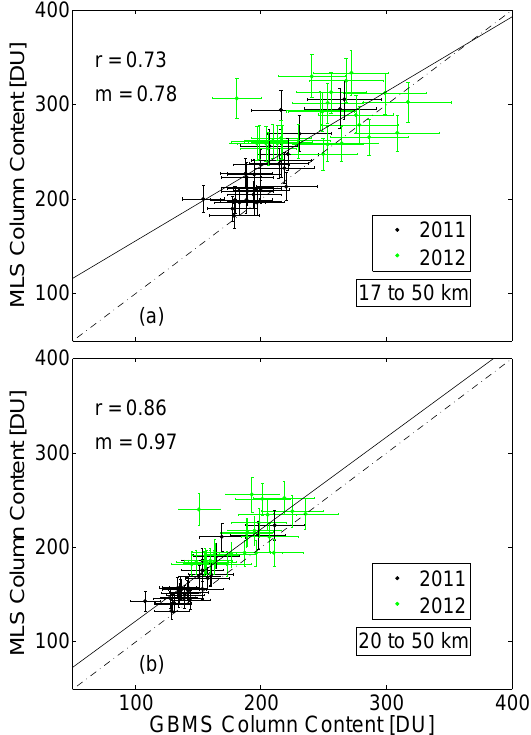
Fig. 5. (a) Scatterplot of Aura MLS against GBMS O 3 column con- tent integrated between 17 and 50km. Different colors denote dif- ferent years: 2011 (black) and 2012 (green). Vertical and horizon- tal error bars represent MLS and GBMS uncertainties, respectively. Linear fit to the data points is displayed with a solid line, and the 1:1 bisector is represented with dash-dotted lines. The correlation coefficient ( r ) and the slope of the linear fit ( m ) are also reported.